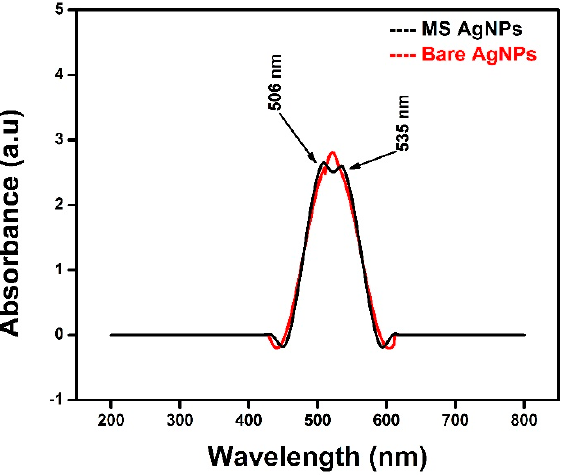
Figure 4. UV–vis spectra of bare AgNPs (red spectra) and MS-AgNPs (black